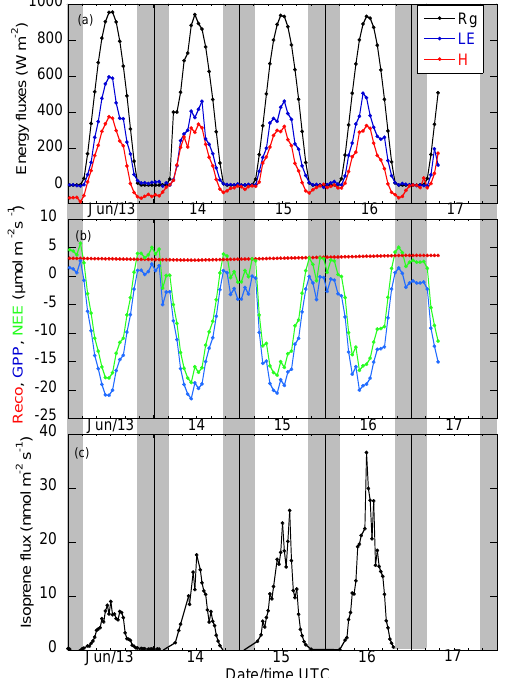
Figure 6. A 4-day time series of (a) global radiation (Rg), sensi- ble and latent heat ( H and LE), and of CO 2 hourly fluxes from eddy covariance data measured at the O3HP site ( b , June 2012). Reco, GPP, and NEE fluxes stand for ecosystem respiration, gross primary production, and net ecosystem exchange, respectively. We use the convention that negative values of fluxes indicate carbon up- take by the forest ecosystem. Panel (c) displays the isoprene fluxes measured concomitantly by the disjunct eddy covariance technique (Kalogridis et al., 2014).